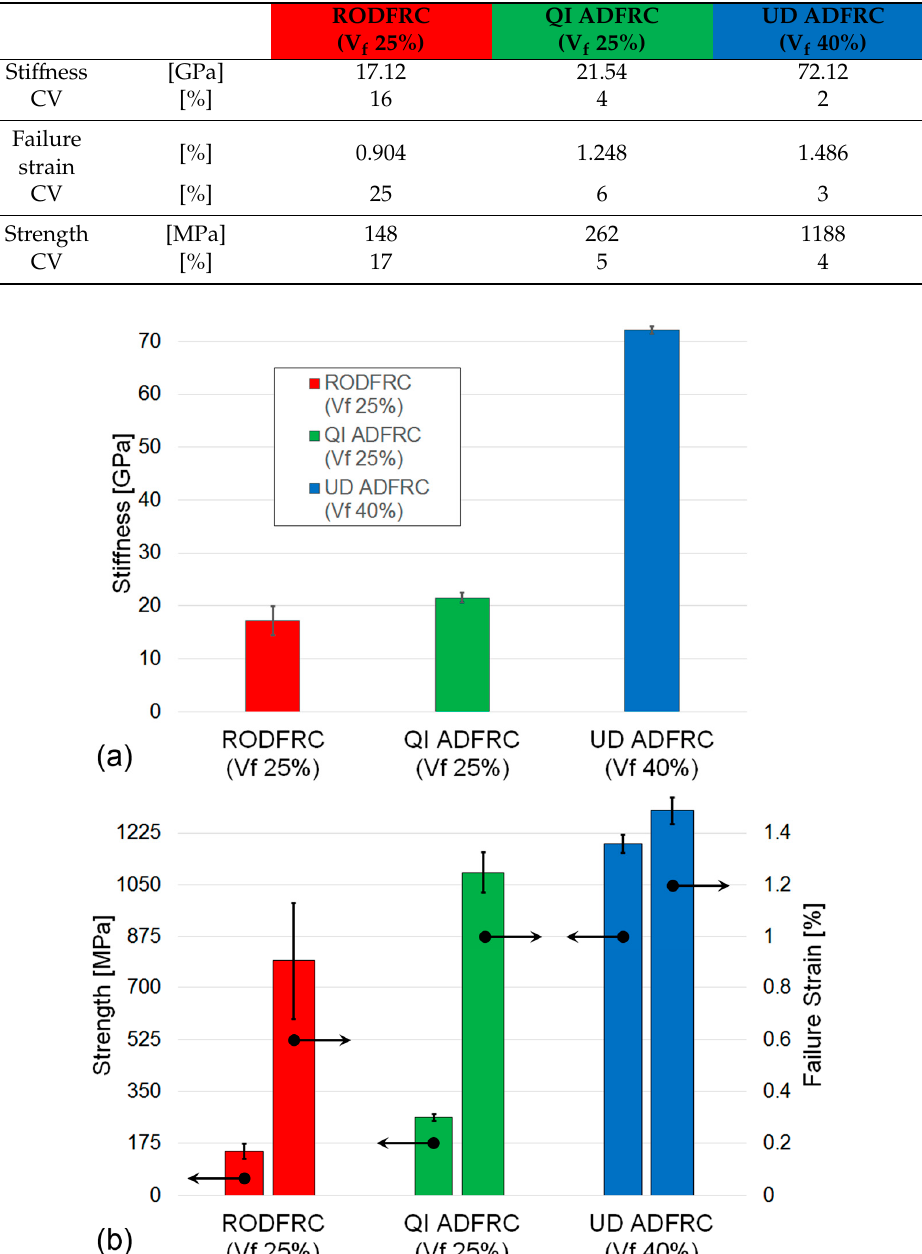
Figure4. 100%HSCdiscontinuousfibrecompositestensiletestresults: ( a )sti ff ness, ( b Figure 4. 100% HSC discontinuous fibre composites tensile test results: ( a ) stiffness, ( b ) failure properties.